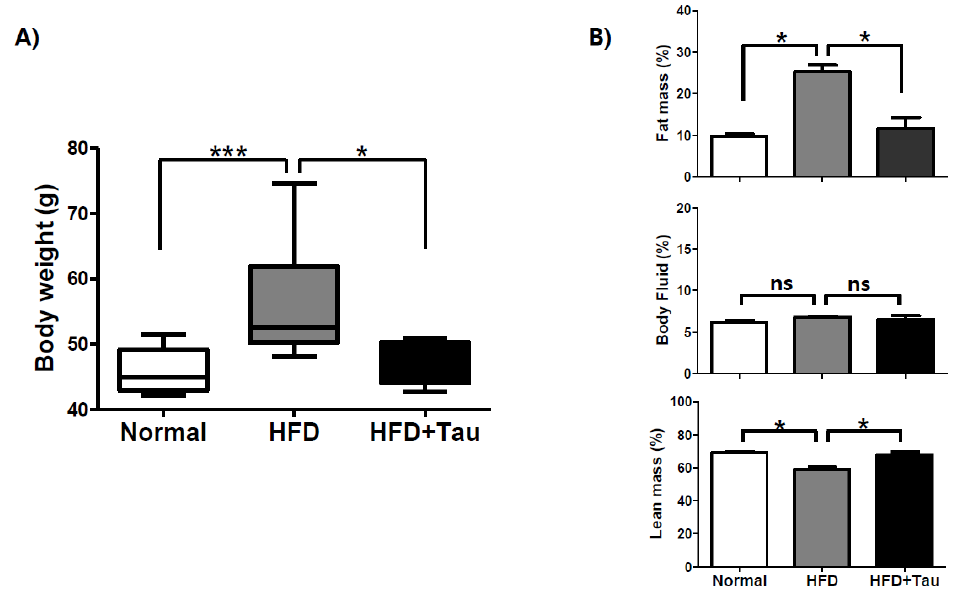
Figure 1. Effect of taurine on body weight loss in high-fat diet (HFD)-fed ICR mice. ( A ) ICR mice were fed a normal chew diet, HFD, or HFD + taurine (2% in drinking water) for 28 weeks ( n = 10/group). They were named as Normal group, HFD group, and HFD + Tau group, respectively. ( B ) Body composition of the three groups ( n = 4) was analyzed with an LF50 body composition analyzer after each meal for 28 weeks. Differences between three groups were analyzed using the nonparametric Kruskal-Wallis test. If a statistical difference was detected ( p < 0.05), post-hoc pairwise group comparisons were performed using Dunn’s test with Bonferroni multiple-testing correction. Differences were considered statistically significantly at p < 0.05. *** p < 0.001; * p < 0.05; ns, not significant.